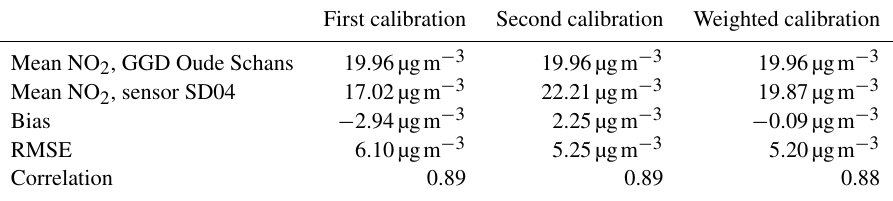
Table 6. Comparison of sensor SD04 with Oude Schans station during the campaign period, according to different